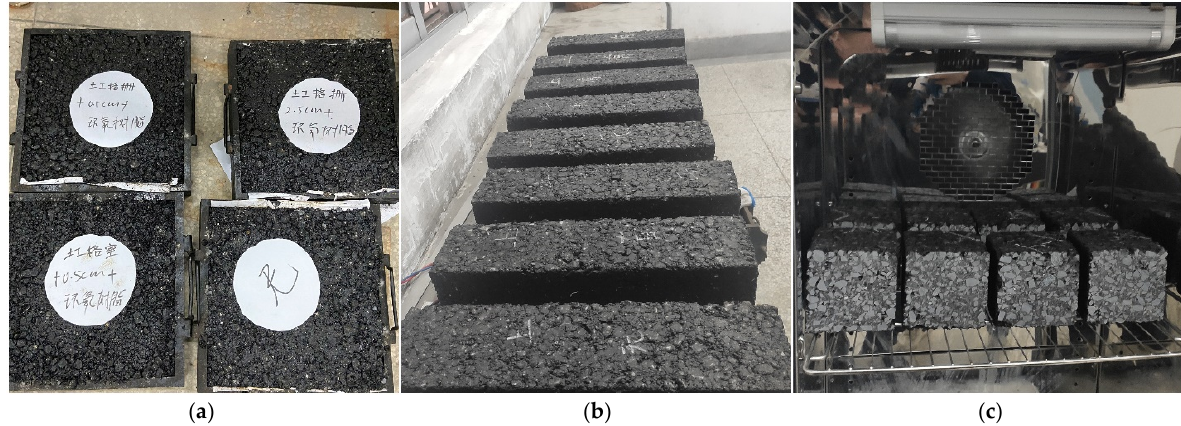
Figure 3. Geosynthetic-reinforced asphalt mixture specimens: ( a ) specimens of rut board; ( b ) beam specimens; ( c ) cube specimen.